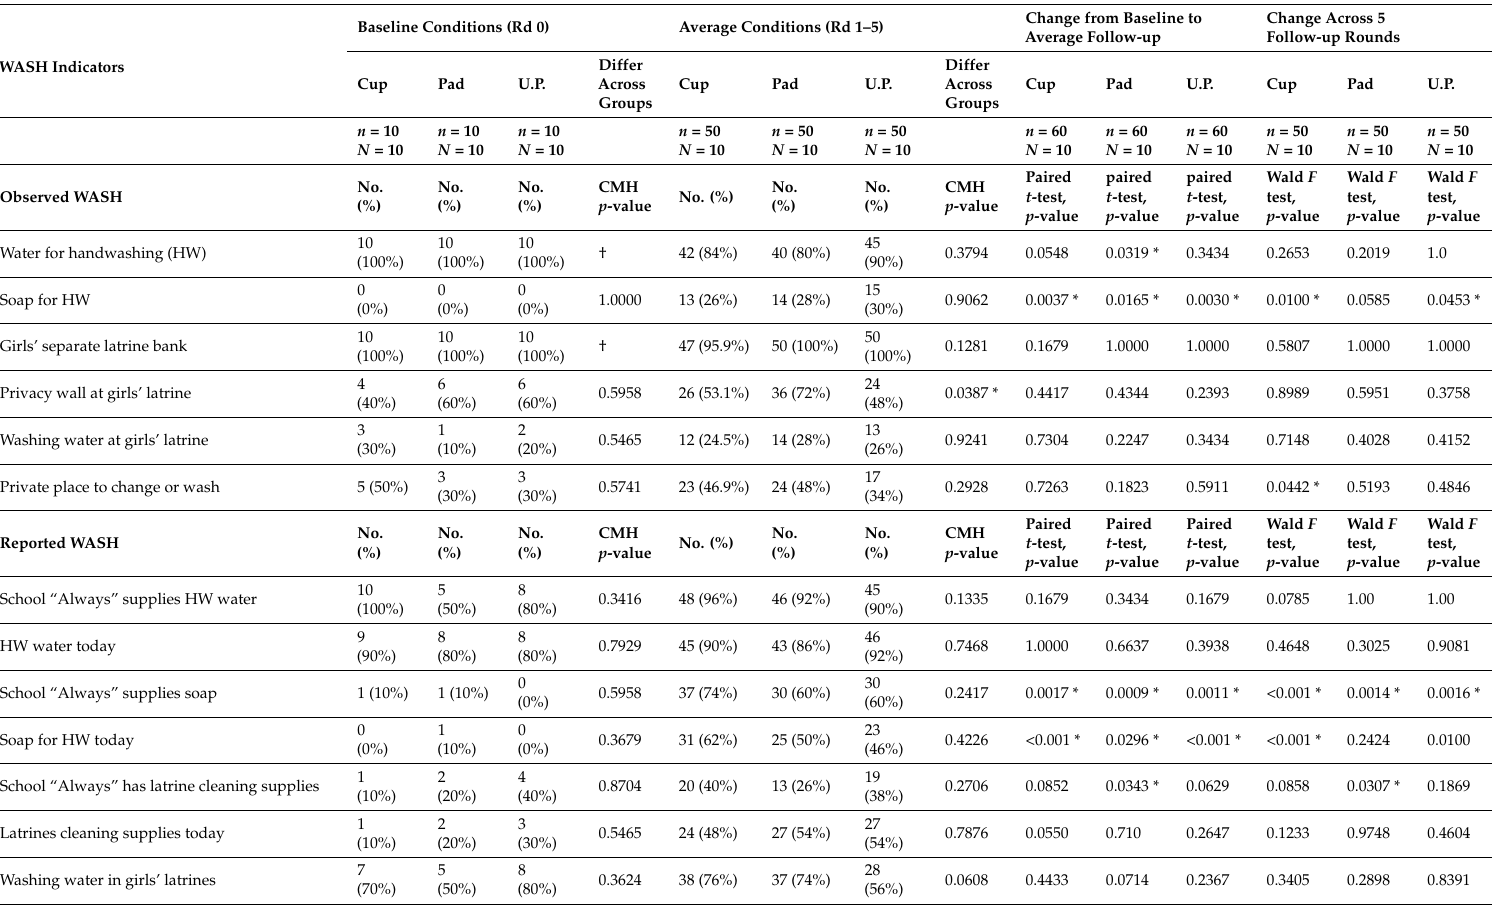
Table 3. School water, sanitation, and hygiene (WASH) conditions at baseline and average over five follow-up rounds, and comparisons western Kenya 2012–2013. WASH Indicators